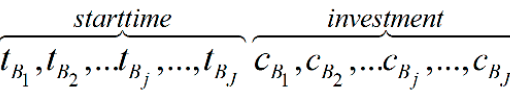
Figure 6. Variable encoding.